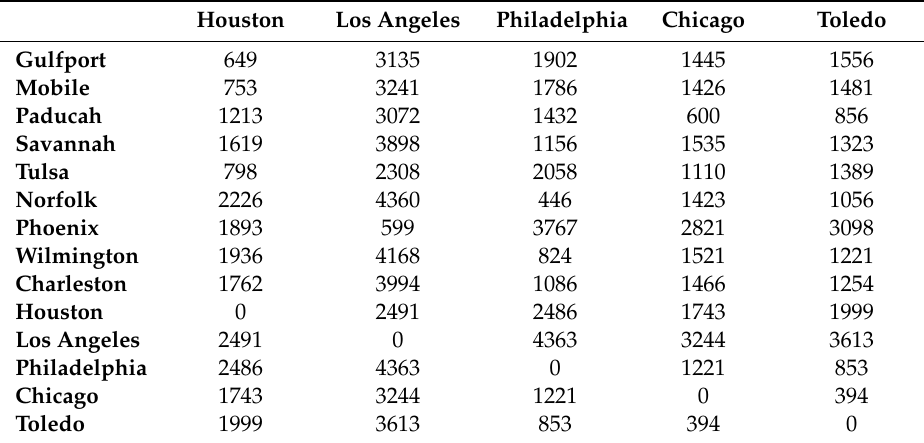
Table A5. Road distances between Transesterification and Demand locations (km).